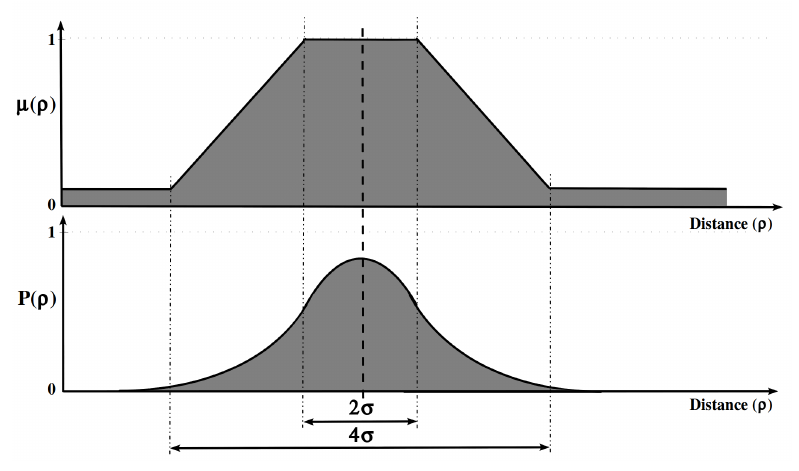
Figure 5. Sensor models used to perform the comparison experiments; correspondence between (upper) fuzzy set and (lower) stochastic Gaussian distribution.